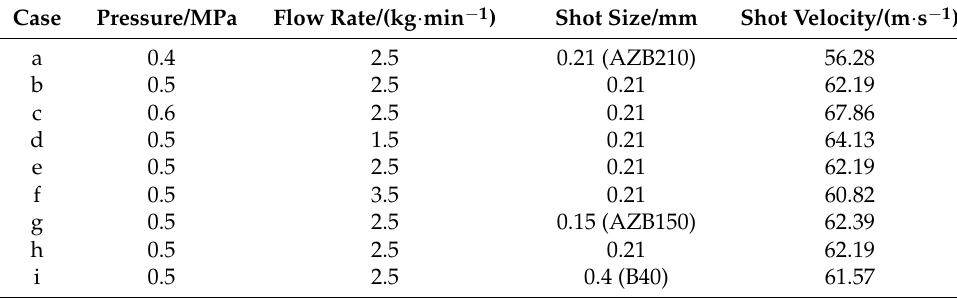
Table 2. The experimental scheme of shot